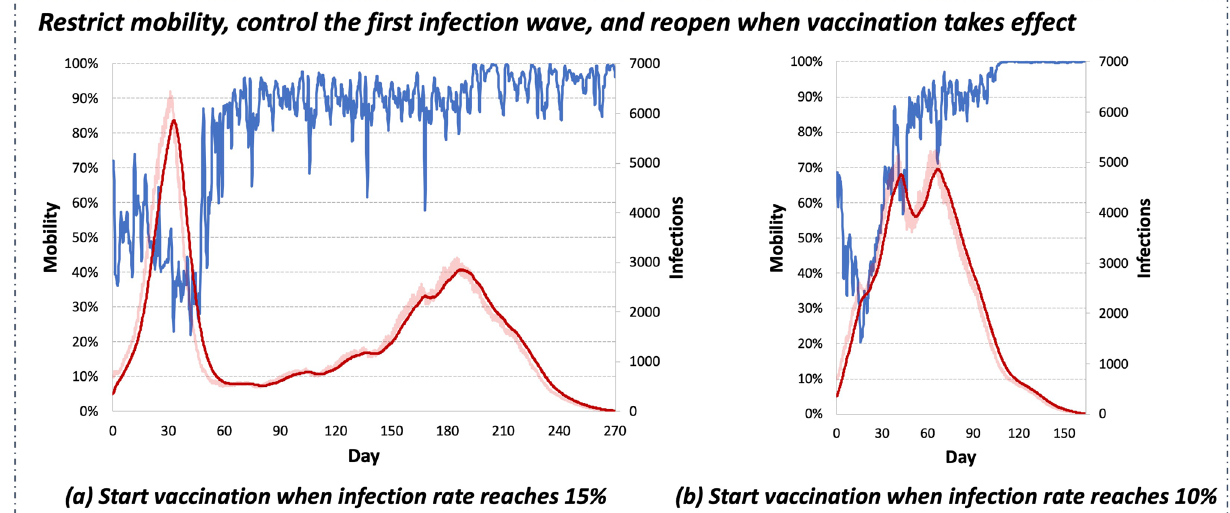
Figure 6. The city lockdown policy reacts differently to different vaccination settings. For both settings, the speed of vaccination is set as 0.5% of the population per day. ( a ) Start vaccination when the total infection rate reaches 15%. ( b ) Start vaccination when the total infection rate reaches